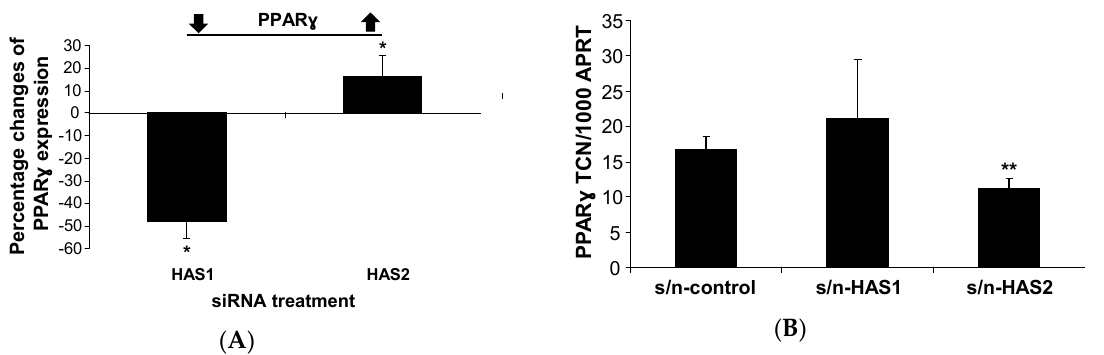
Figure 1. Hyaluronan (HA) from HA synthase (HAS)2 a ff ects peroxisome proliferator-activated receptor gamma (PPAR γ ) transcripts. Subcutaneous preadipocytes / fibroblasts (PFs) ( n = 4) were cultured until ~90% confluent, treated with HAS siRNA ( A ) or a hyaluronan-enriched supernatant ( B ) from HAS1 or HAS2 stable expressing HEK293 cell lines in a serum-free medium for 24 h, compared to scrambled siRNA or a supernatant from HEK293 cells with empty vector controls, respectively. PPAR γ transcripts were measured by Q-PCR. Results are expressed as increased or decreased percentage changes in comparison to the controls ( A ) or transcript copy number (TCN) per 1000 copies of housekeeper gene (adenosine phosphoribosyl transferase, APRT) ( B ). Histograms = the mean ± SEM of all samples studied. * p < 0.04; ** p ≤